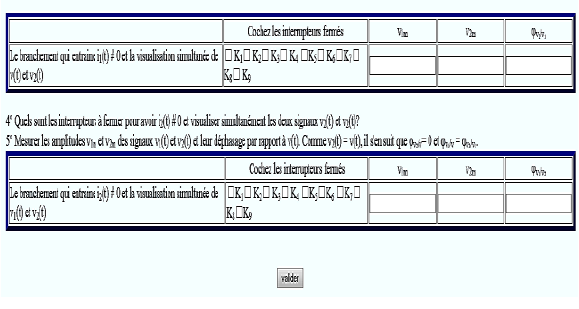
Figure 7. Student RPW